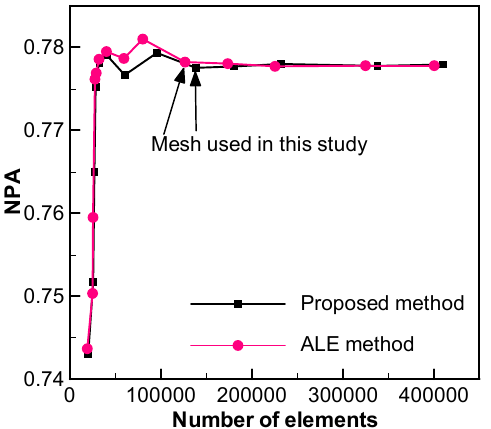
Figure 3. Normalized power absorption (NPA) as a function of the total number of elements for the proposed method and the arbitrary Lagrangian–Eulerian (ALE) method.